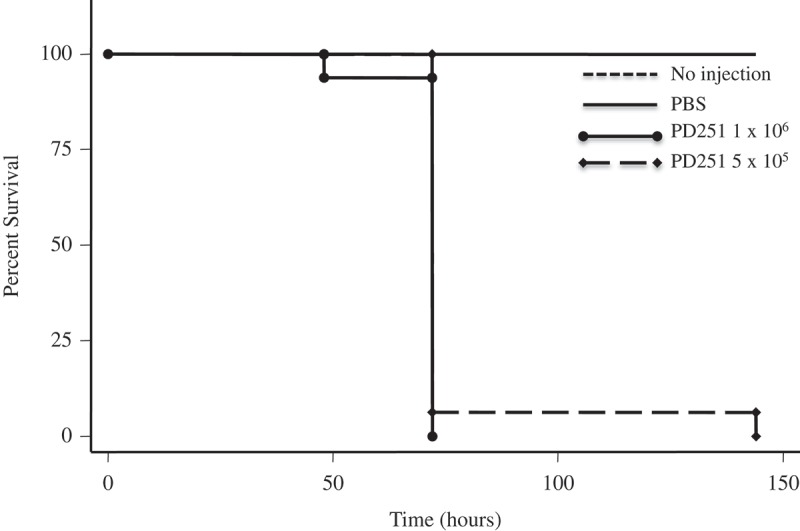
P. destructans reduced survival of the G. mellonella infection host. Larvae infected and incubated at 15°C experienced decreased survival compared to larvae injected with PBS per dosage indicated.